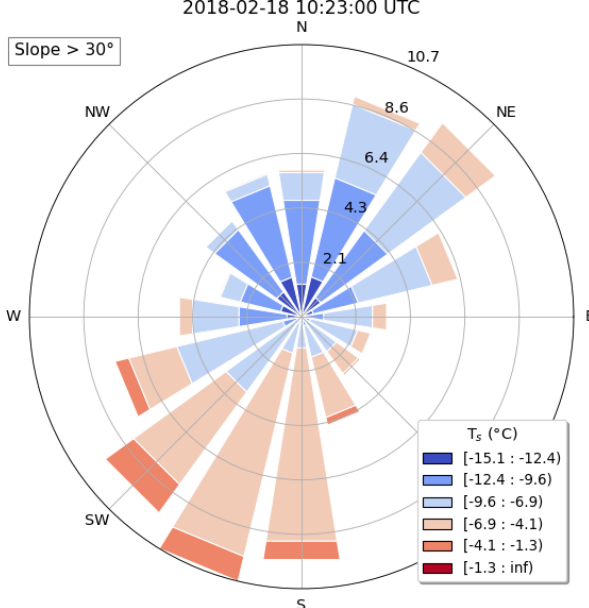
Figure 12. Distribution of simulated surface temperature as a func- tion of the aspect for slopes larger than 30 ◦ . The radius of each of the 16 sectors corresponds to the normed (displayed in per cent) quantity of